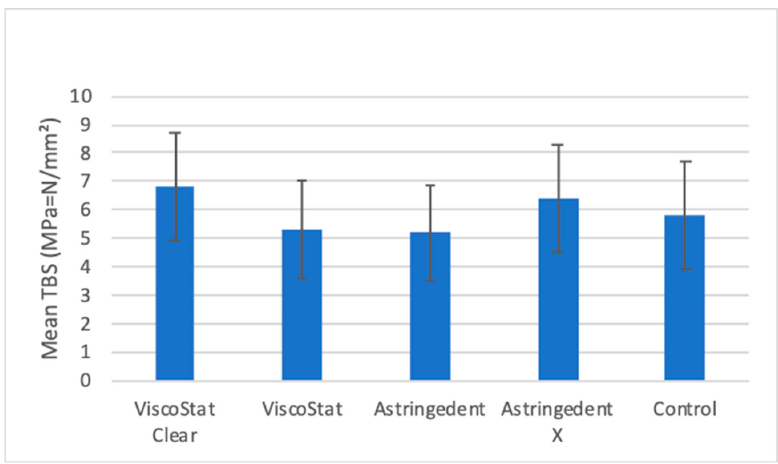
Figure 9. Mean RS values and their respective standard deviations for all groups.